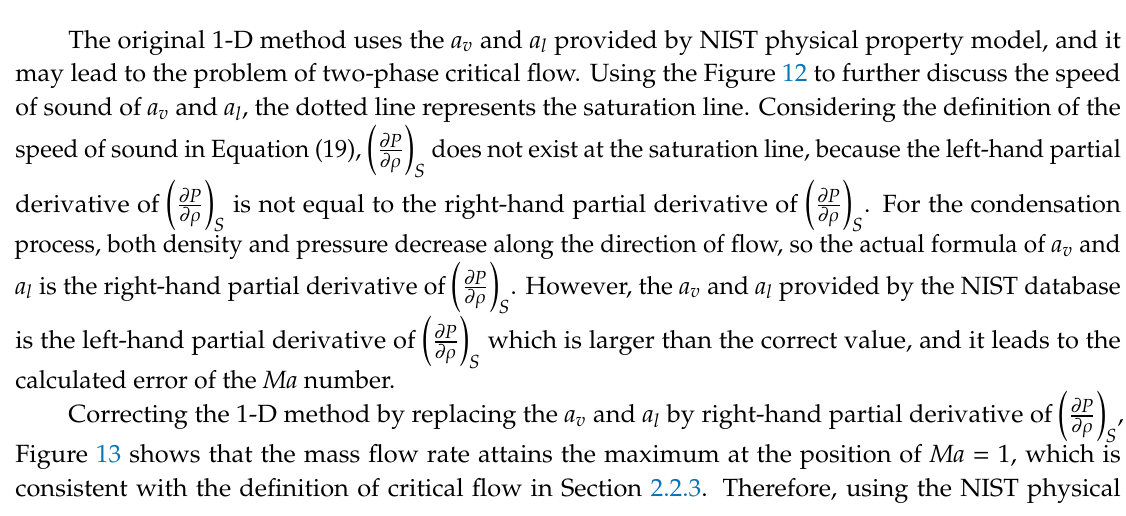
Figure 13. The curve of sealing performance of the round hole calculated by the corrected 1-D method. 4. Results and Discussion This paper investigates three types of labyrinth, namely round-hole, see-through, and staggered labyrinths. Firstly, existing experimental data are compared to verify the accuracy and applicability of the 1-D method proposed in this paper on the labyrinths with different sealing structures which are summarized in Table 6. Secondly, the influence of different sealing structure on the sealing effect is studied by using the 1-D method, and the law of designing the sealing structure is analyzed in advance.